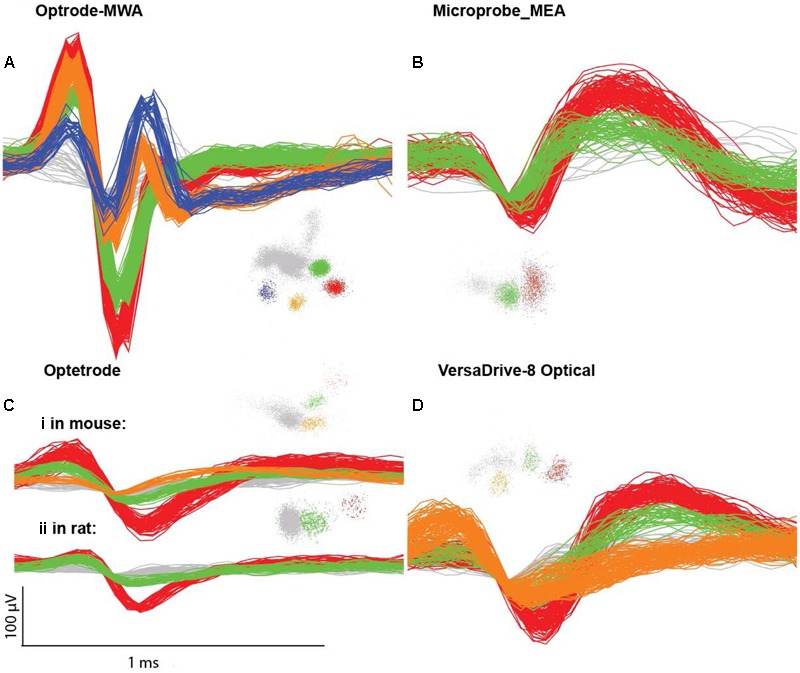
Single unit examples. (A) Waveforms and clusters from an optrode MWA, (B) Microprobes MEA, (C) Optetrode (i) from a mouse and (ii) from a rat, (D) VersaDrive 8 Optical. Colored clusters represent hand sorted units visualized in PC1 versus PC2 feature space (Plexon OFS). The noise waveforms and clusters are marked in gray.